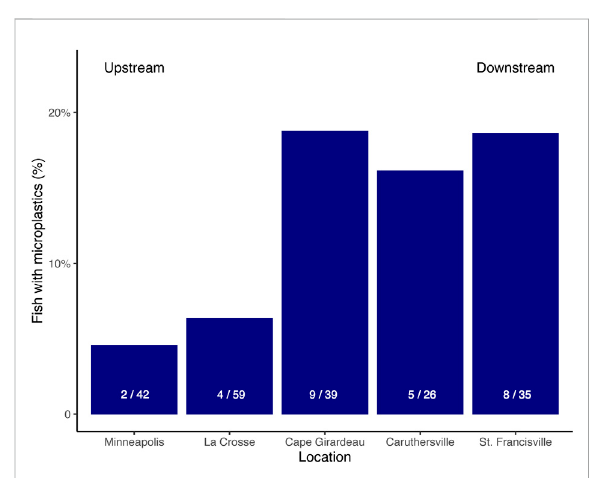
FIGURE 2 Percentage of fi sh samples by location that contained microplastics. Fish were considered as either containing or not containing microplastics; i.e., abundance of microplastics was not accounted for in this representation. Sites are ordered from upstream to downstream and the white fraction with each bar represents the number of fi sh with microplastics to the total number of fi sh sampled.